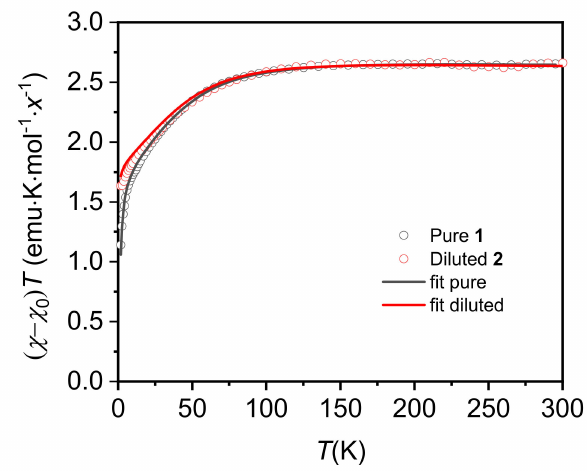
Figure 4. Temperature dependence of ( χ − χ 0 ) T for pure 1 ( x = 1) and diluted compound 2 ( x = 0.2), measured at H = 1 kOe. In line are shown the simulated curves as obtained from Equation (2) with the D , E, and g ’s from the ab initio calculations of 1 and 2 and using J as a fitting parameter J /k B = − 0.32 K for 1 . Experimental data were corrected from a temperature independent term, χ 10 − 4 emu/mol for 1 and χ 0 = − 1.7 × 10 − 3 for 2 .